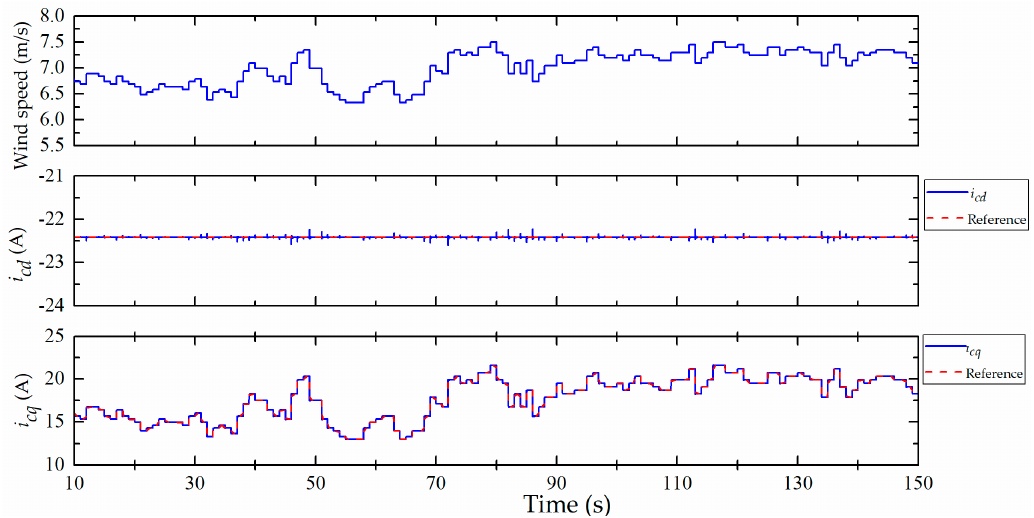
Figure 14. Dynamic responses of the CW currents in Case I.